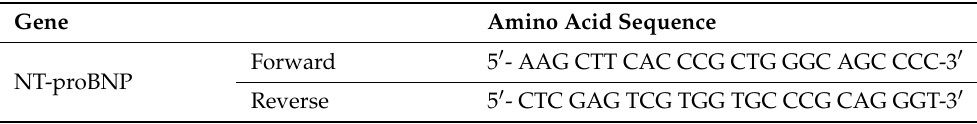
Table 2. PCR primer sequences for the amplification of